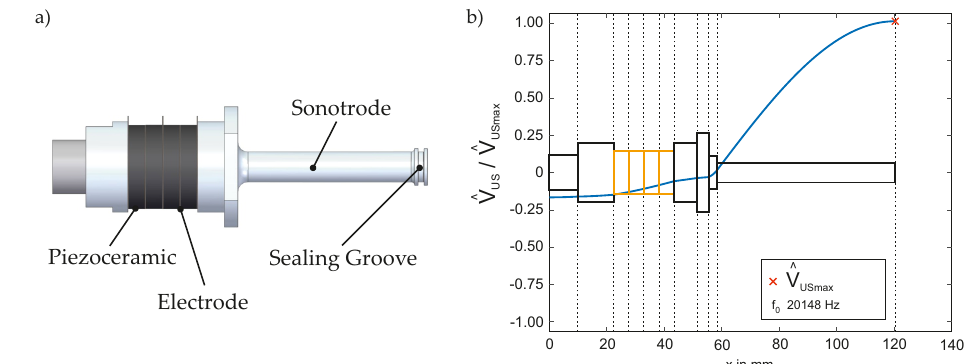
Figure 3. ( a ) Structure of the ultrasonic transducer. ( b ) Longitudinal velocity distribution.